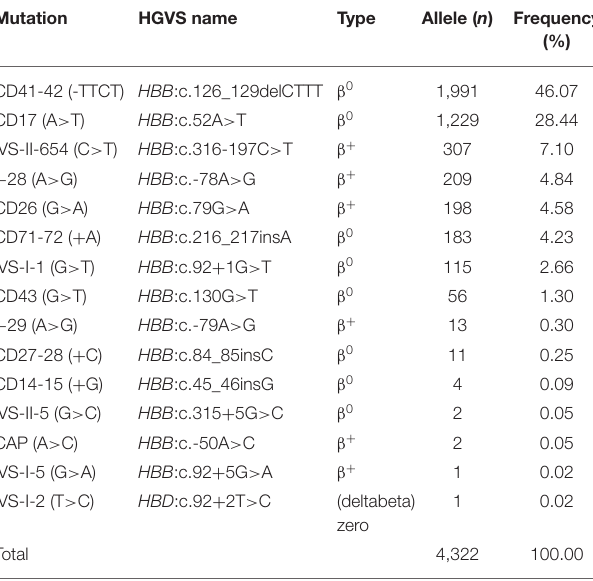
TABLE 4 | Allele frequency of β -thalassemia among the 71,459 children in Guangxi.